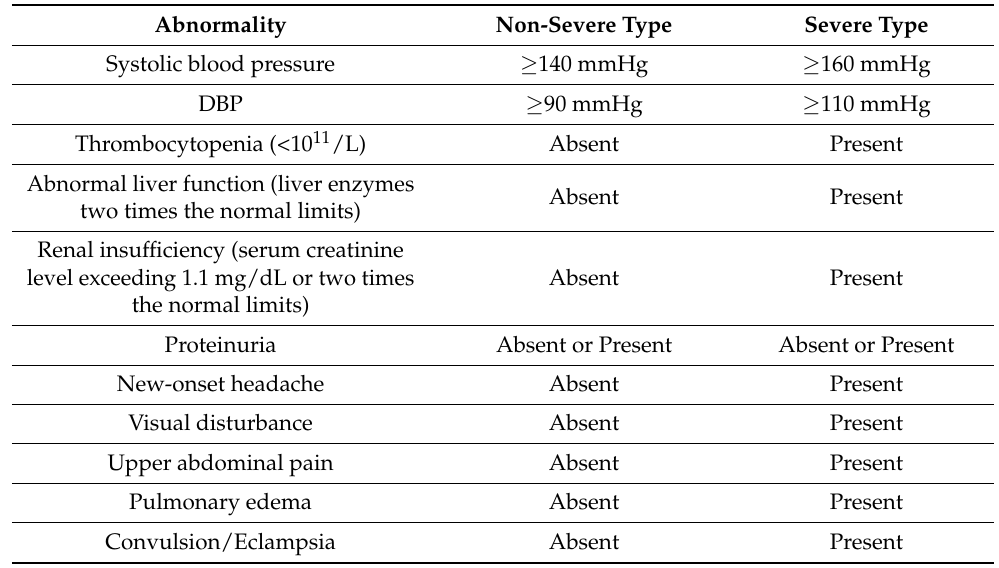
Table 2. Classification of preeclampsia according to severity. Abnormality Non-Severe Type Severe